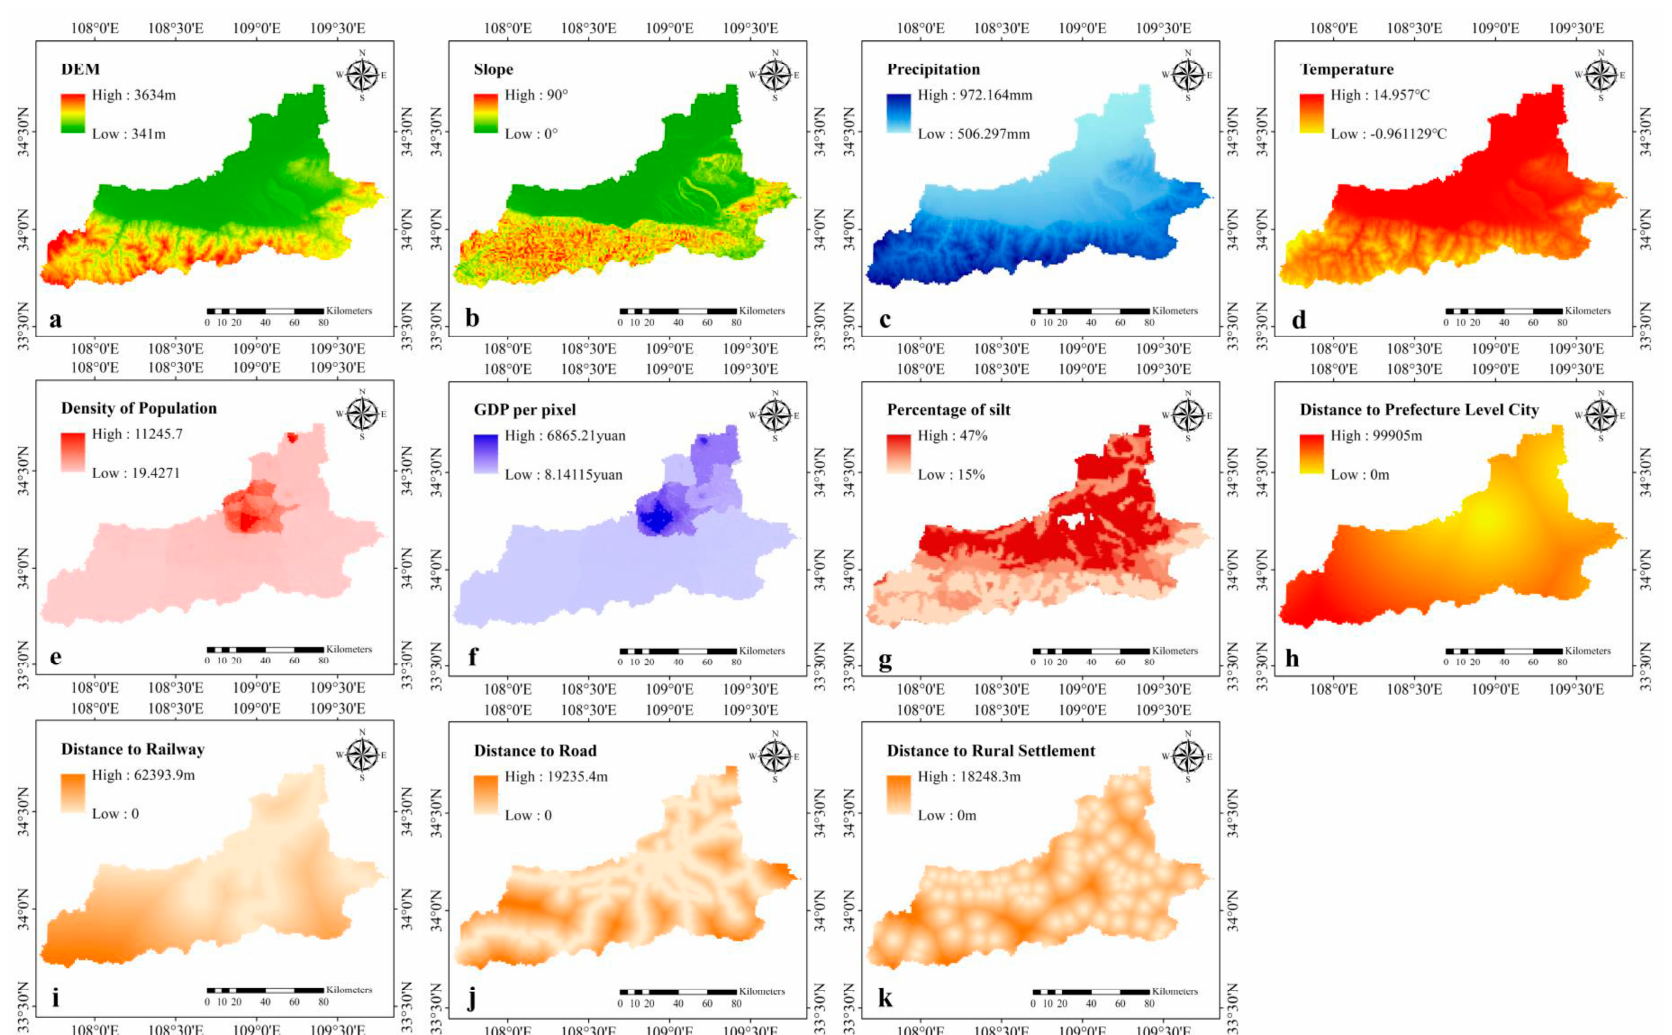
Figure 2. Various influencing factors in Shaanxi Province. ( a ) Digital elevation model (DEM), ( b ) slope, ( c ) precipitation, ( d ) temperature, ( e ) population density, ( f ) GDP, ( g ) percentage of silt, ( h ) distance to the city center, ( i ) distance to railways, ( j ) distance to roads and ( k ) distance to rural settlements.